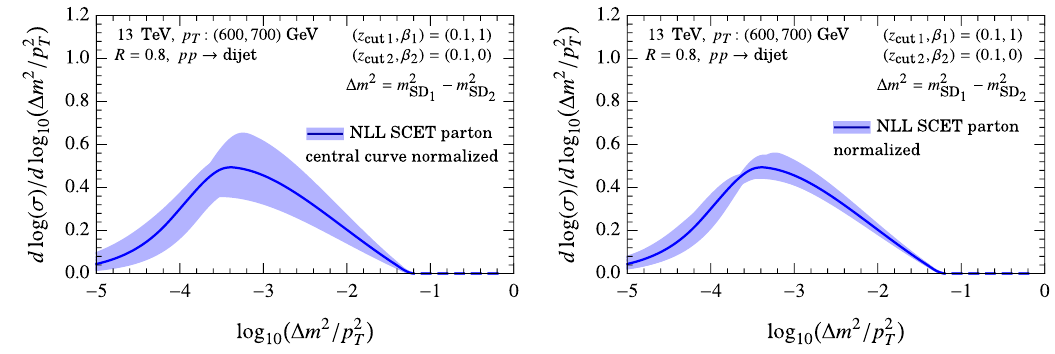
Figure 12 . An example of collinear drop distributions showing uncertainty bands at NLL order. The left panel includes the normalization uncertainty, while the right panel only includes shape